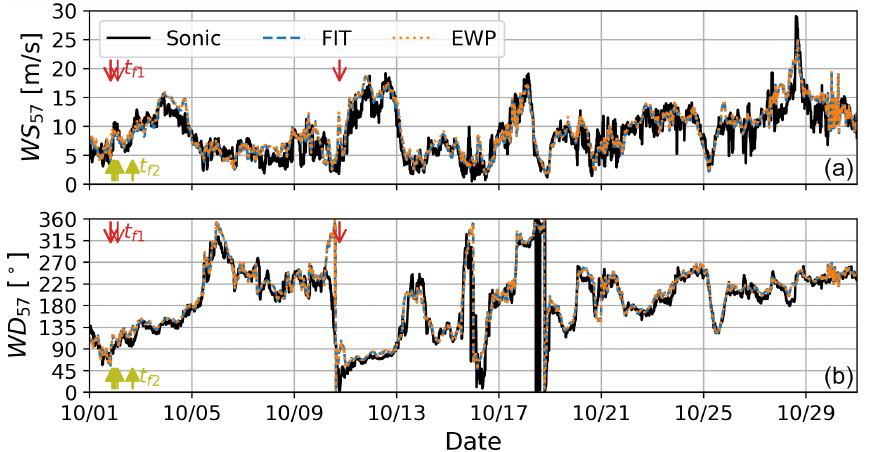
Figure 9. Time series of wind speed (WS, a ) and wind direction (WD, b ) at 57m height for October 2013 for sonic mast measurements (black), and WRF results interpolated to the mast location for the NYRØ scenario for EWP (dotted orange) and FIT (dashed blue). The vertical arrows mark the time stamps t of the two filter methods f1 (red) and f2 (olive) according to Table 6. See Tables 6 and 7 for the